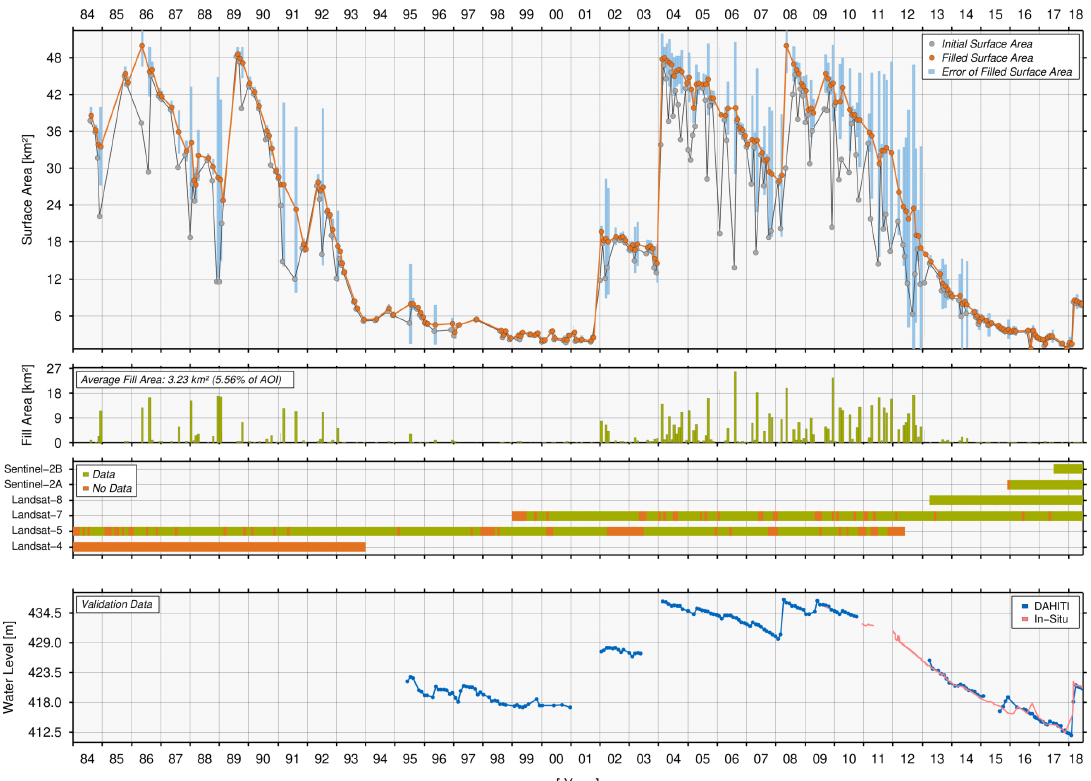
Figure 16. Water surface area time series (orange) and their errors (blue) of Poço da Cruz Reservoir. Additionally, the initial surface area with data gaps (gray) and the filled area (green) are shown. Also, the data availability of monthly optical images from Landsat and Sentinel-2 is presented. Finally, the water level time series from in situ stations and DAHITI which used for validation is shown.